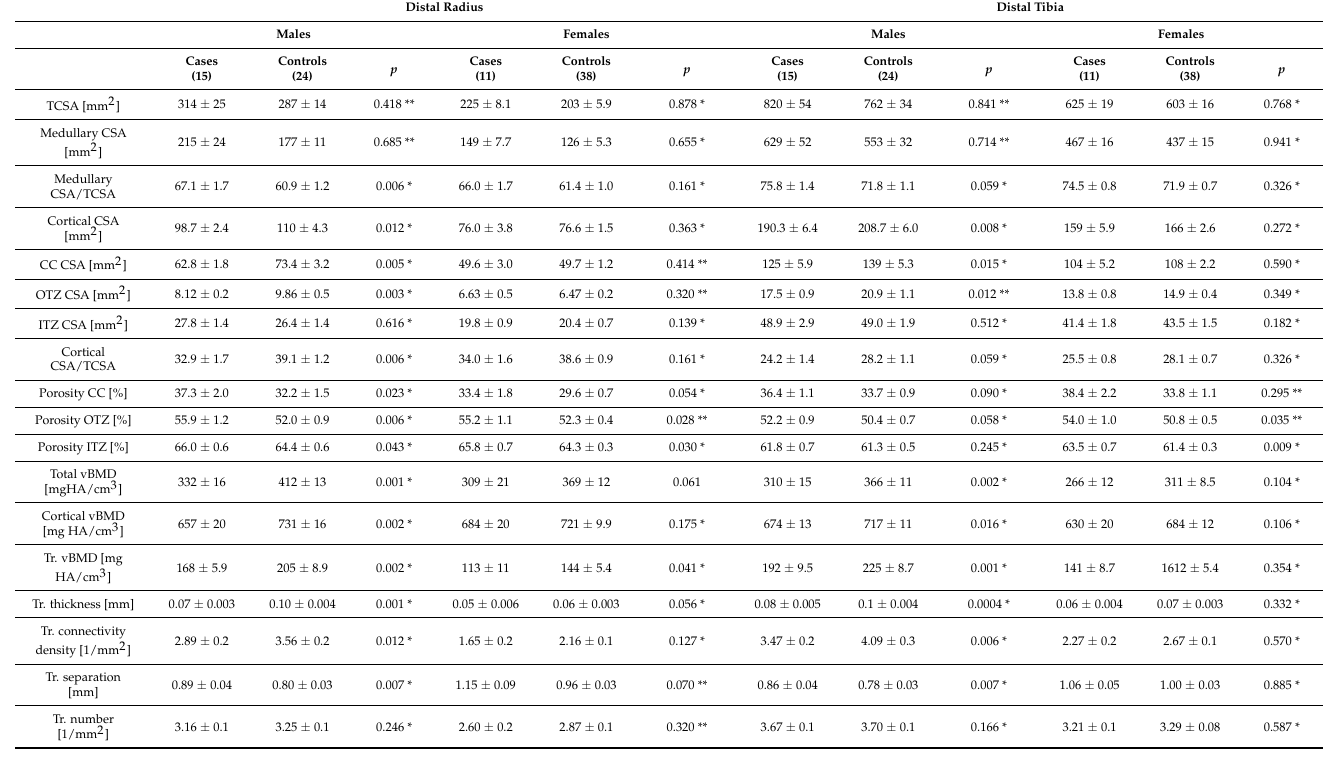
Table 2. Comparison of microarchitecture of the distal radius and distal tibia in cases and controls.